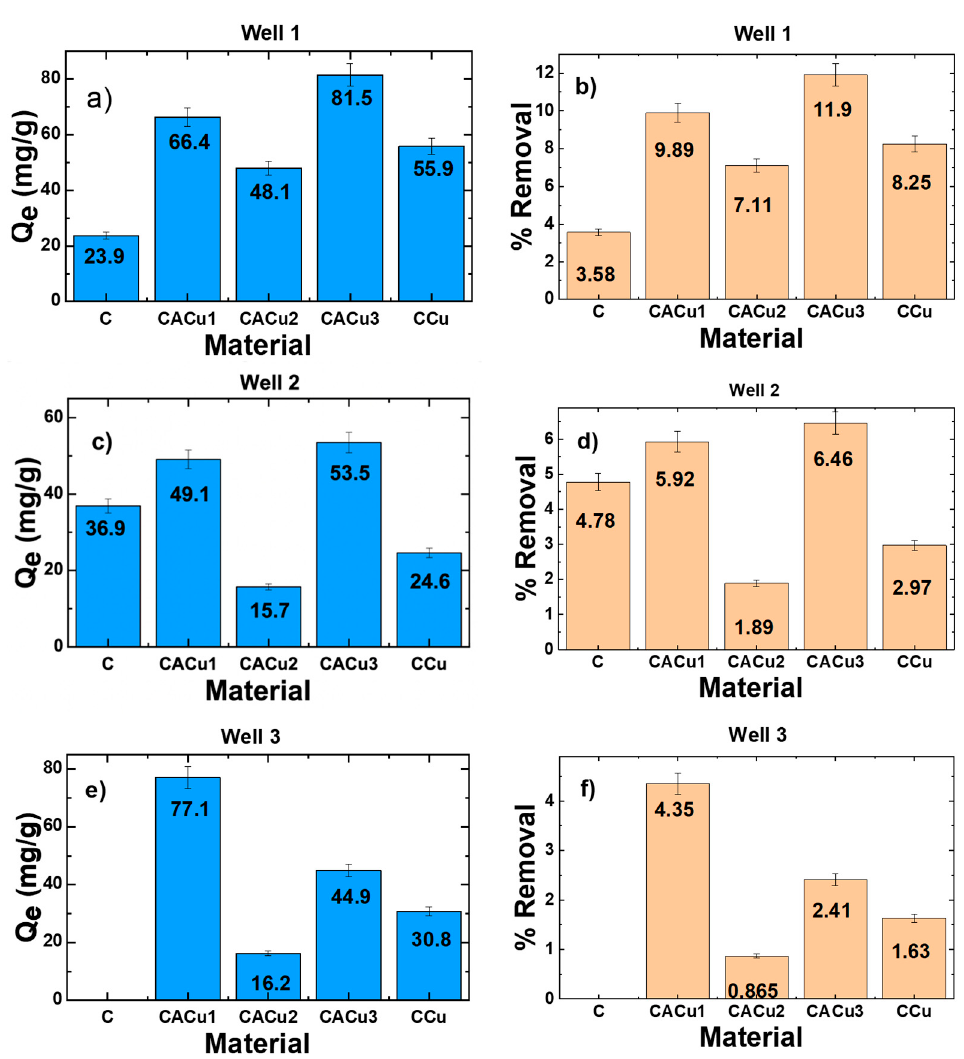
Figure 7. ( a – f ) Experimental results of Q e and sulfate removal (%) by five sorbents in Well-1, -2 and -3 groundwater